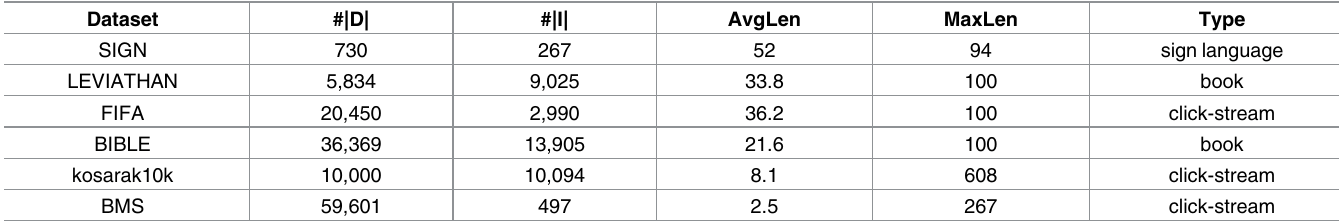
Table 6. Characteristics of the datasets.